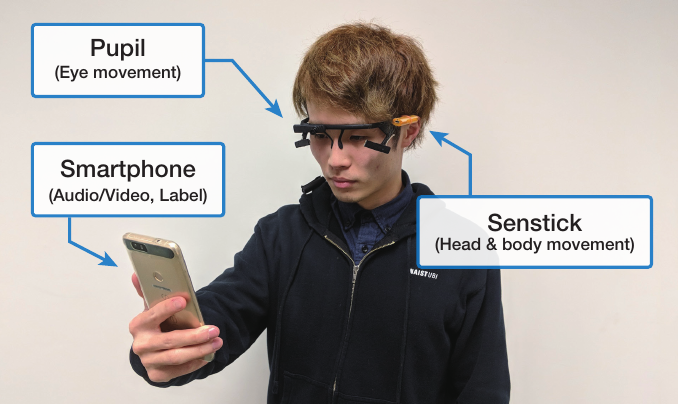
Figure 2. Devices for data collection during sightseeing: pupil [32], SenStick [33], and